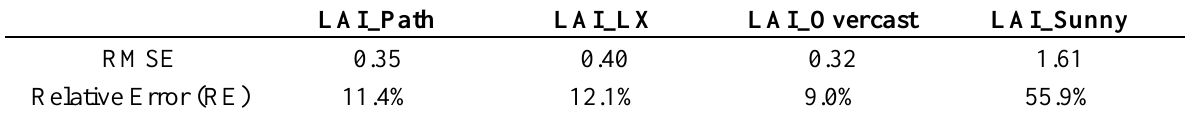
Table 2. The statistical results for the performances of four different LAI retrieval methods from 22 images in the principal plane and in the cross plane. The four methods including LAI_Path, LAI_LX, LAI_Overcast, and LAI_Sunny are the same as in Figure 9. LAI_Path